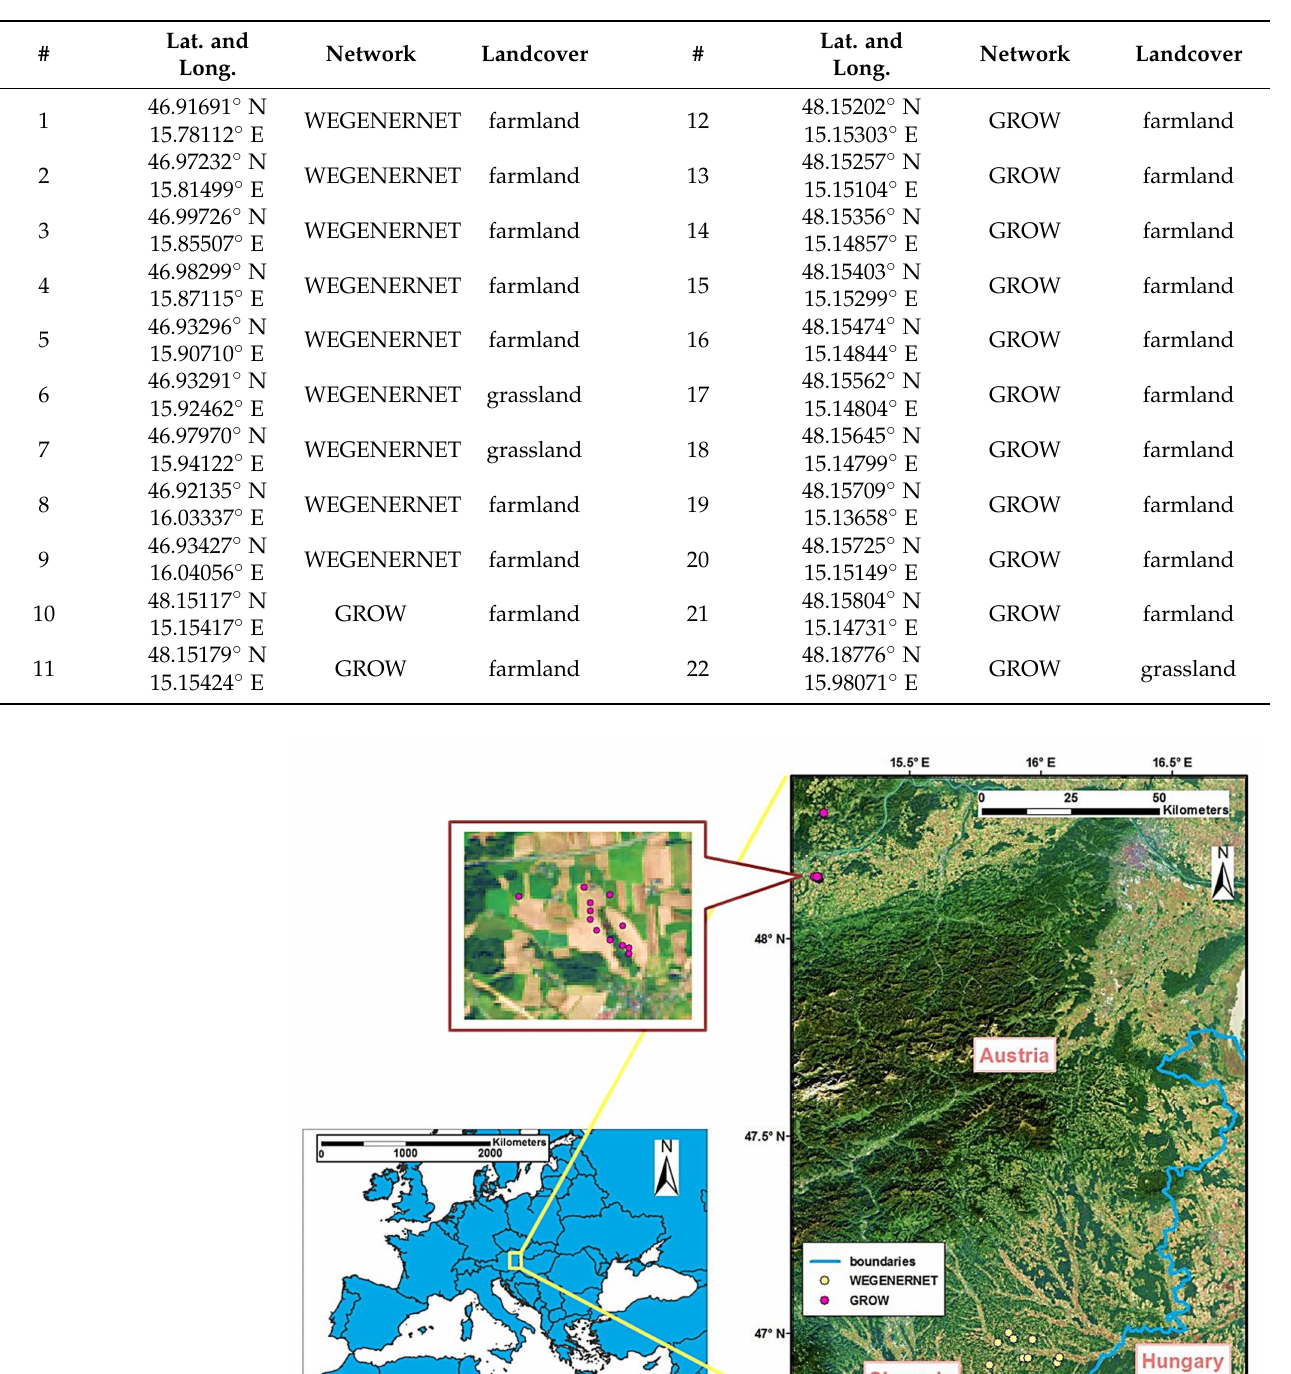
Table 1. Information of monitoring sites in the study area.